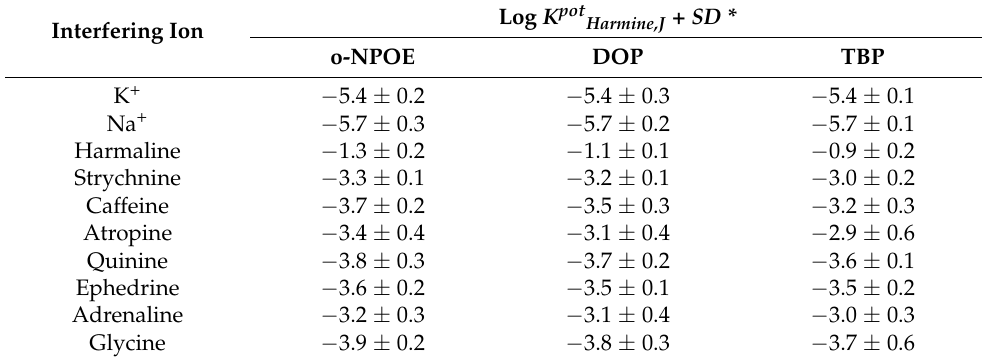
Table 2. Effect of solvent polarity on the selectivity behavior of harmine based